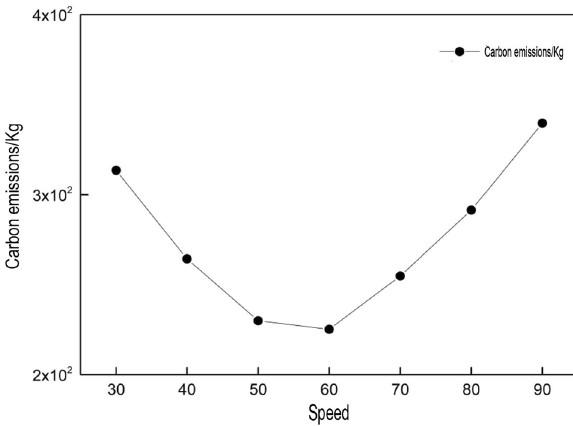
Figure 3. Effect of various speeds on carbon emission.